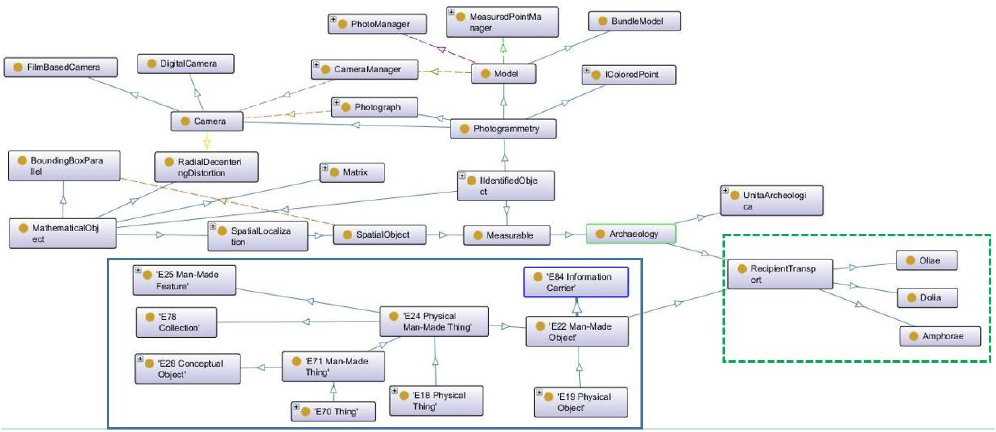
Figure 14. Partial view of the GROPLAN ontology and the link with CIDOC-CRM. (Screen shot taken